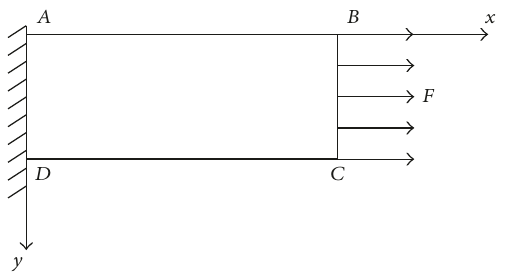
Figure 1: Transverse and longitudinal vibrations of a thin-walled plate. Figure 2: Boundary conditions of a plate.